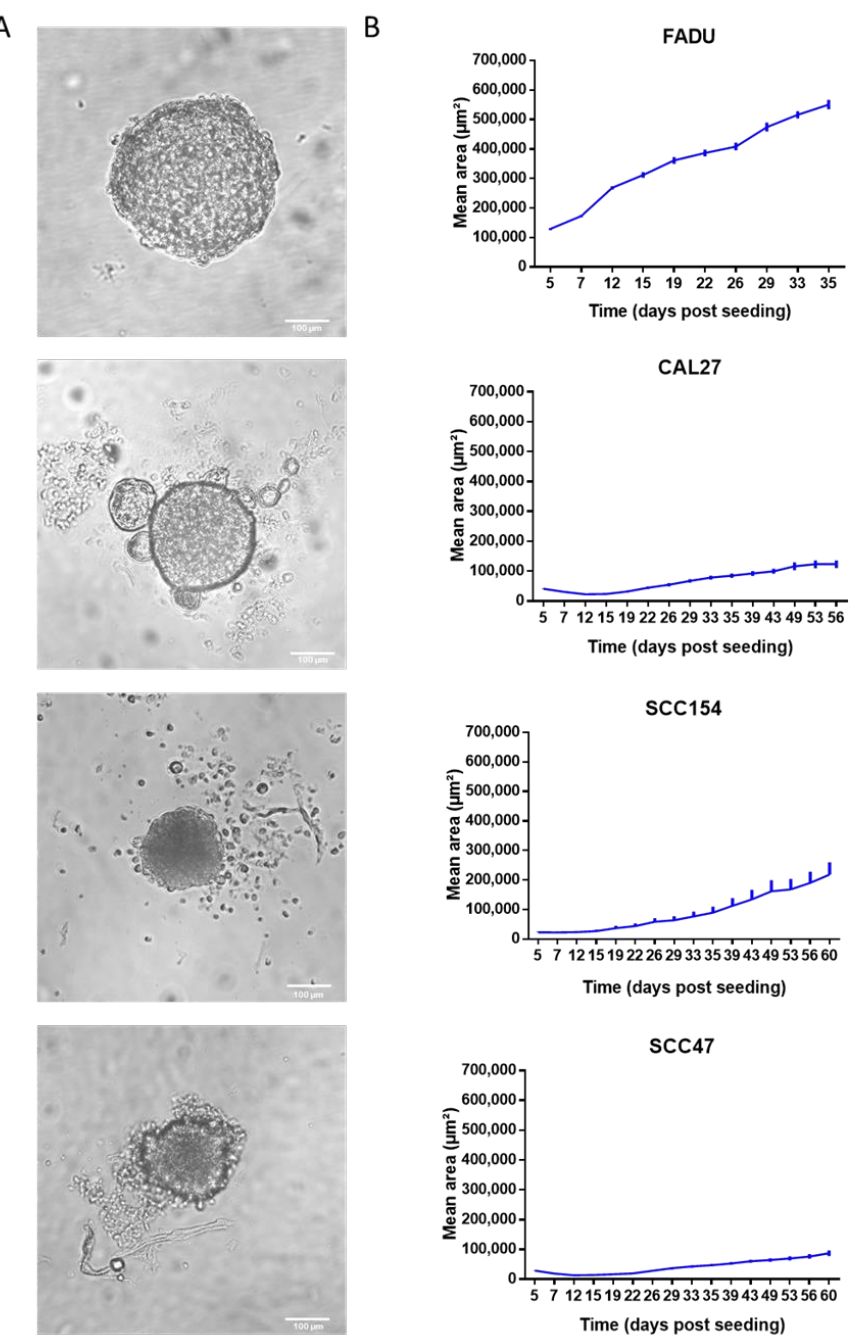
Figure 1. HPV-negative and HPV-positive HNC cells formed 3D spheroids. ( A ) Images of HPV-negative FADU and CAL27 spheroids and HPV-positive SCC154 and SCC47 spheroids taken on day 5. Scale bar, 100 µ m. ( B ) Absolute tumor growth curves of HPV-negative FADU and CAL27 and HPV-positive SCC154 and SCC47 spheroids. Day 1 indicates the day of seeding. Data are presented as mean ± s.e.m., n =